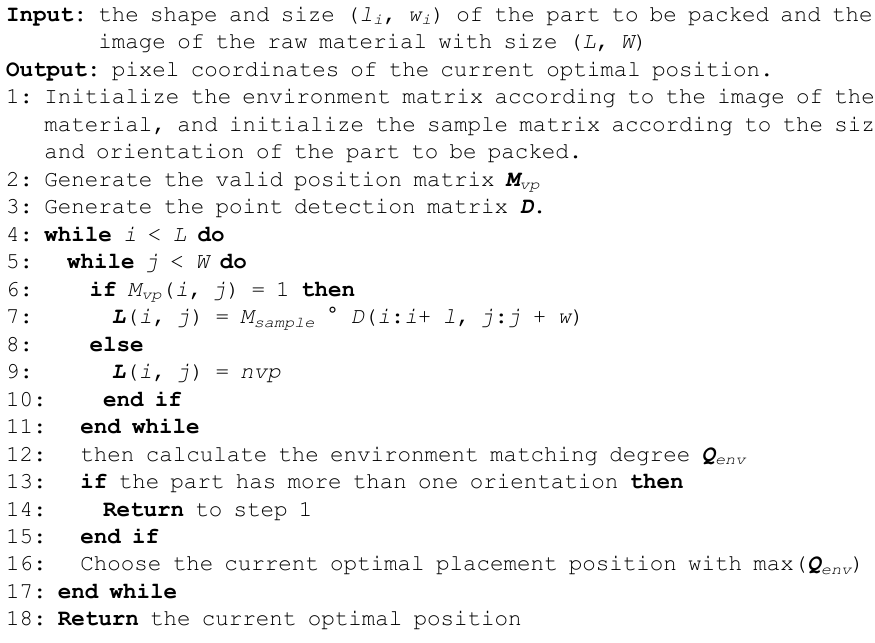
Algorithm 1 Covering, corner-searching and